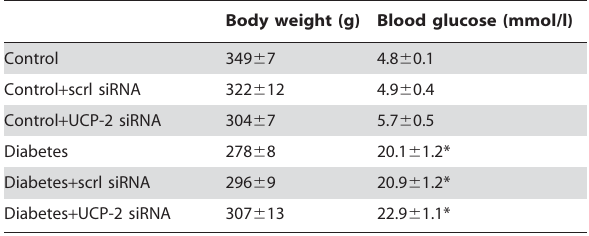
Table 1. Blood glucose and body weight in control and diabetic animals with and without siRNA